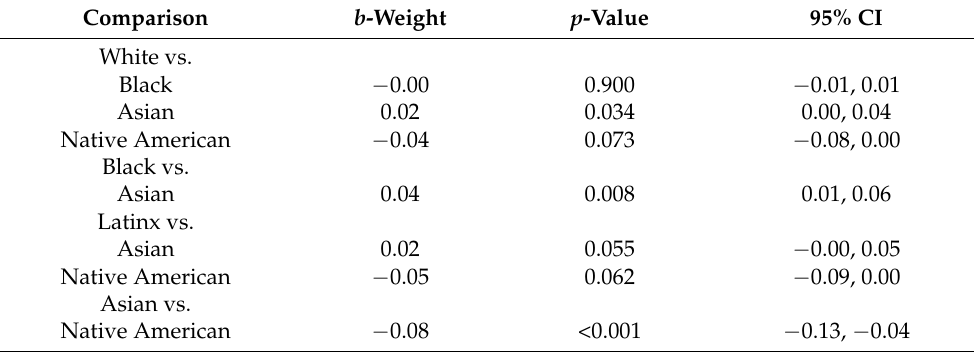
Table 5. Main effect of race/ethnicity on arrest probability trajectory controlling for covariates. Comparison b